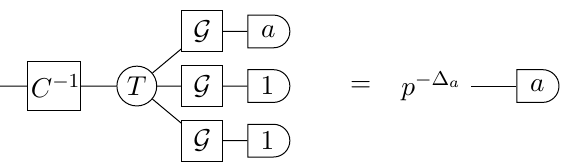
Figure 6. The contribution from the insertion of a single non-trivial operator a on the boundary gets renormalized by p (cid:0) (cid:1) a as we move one step into the